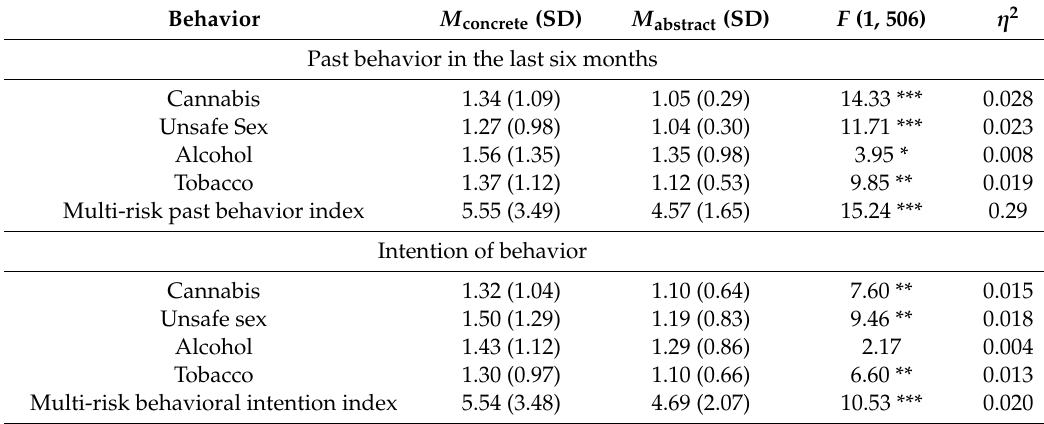
Table 4. Contrast between the concrete and abstract mindset in risk behaviors and intention of risk behaviors.